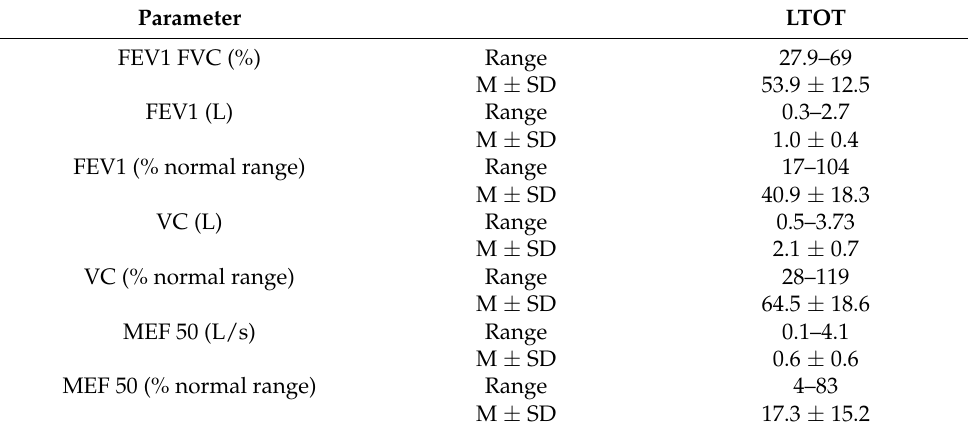
Table 2. Assessment of lung function in COPD patients ( n =